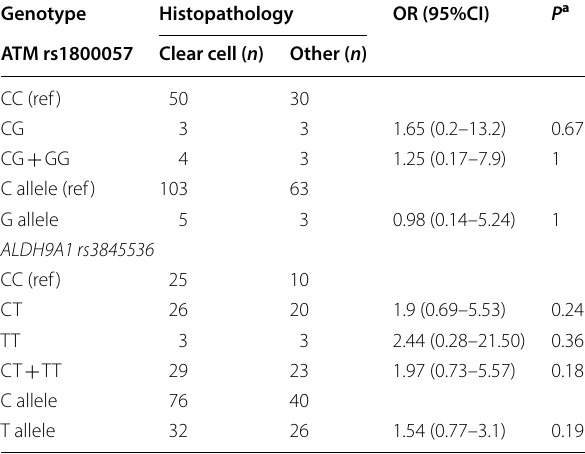
Table 4 Association of the ATM rs1800057 and ALDH9A1 rs3845536 genotypes with RCC histologic